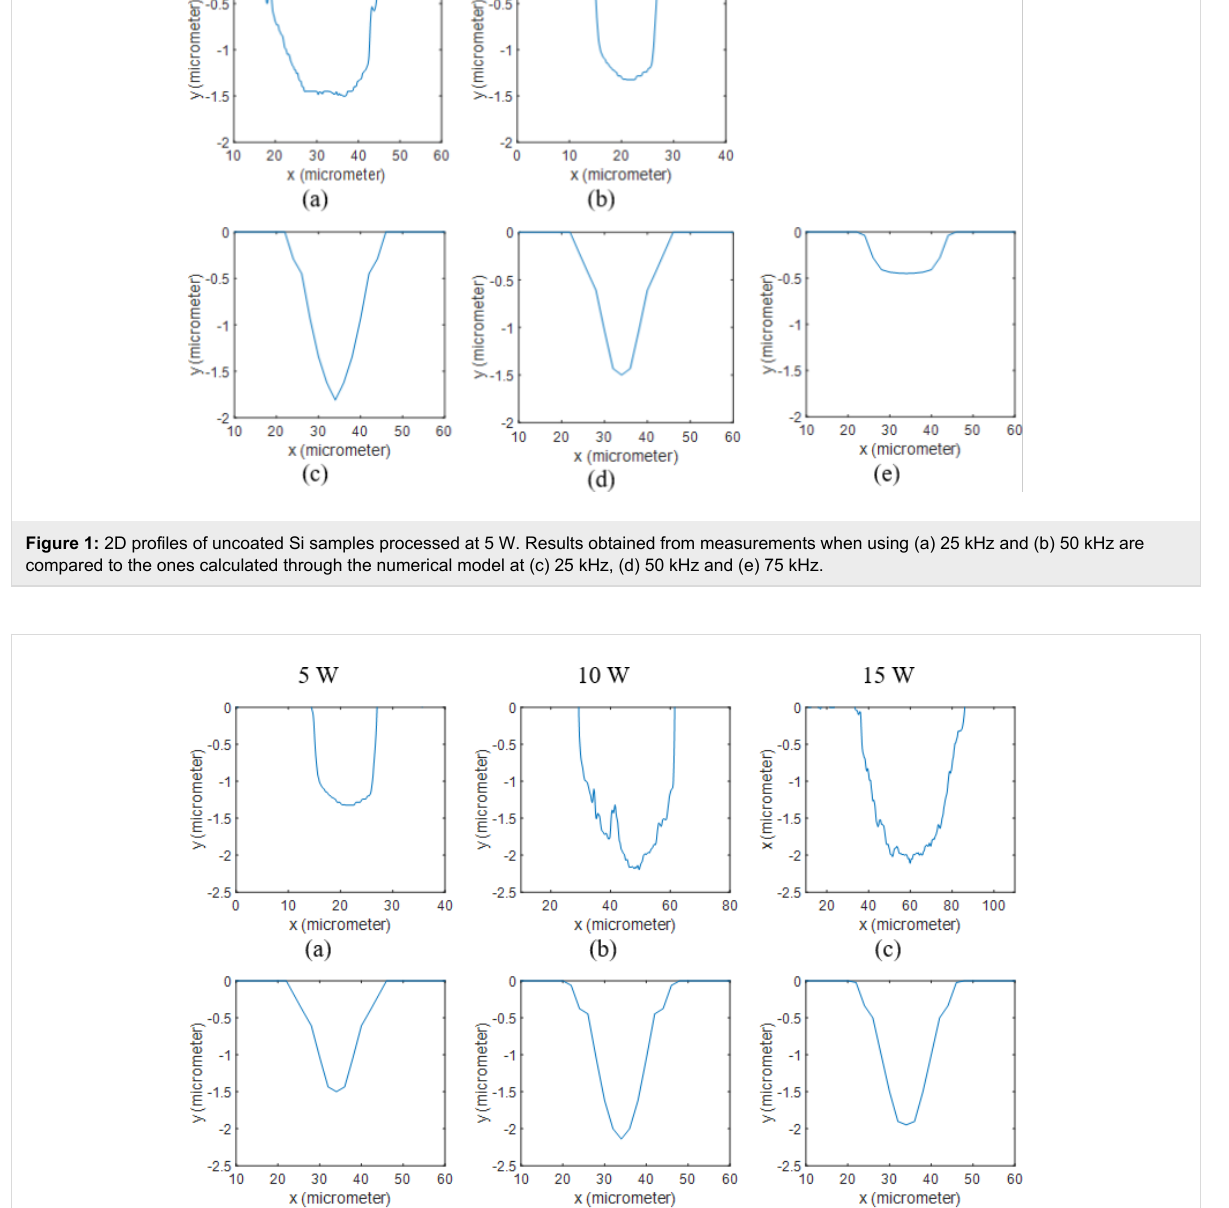
The diameters of the holes at low frequencies and high powers are slightly larger in the experimental results. The laser-driven shock wave and the flow of the molten silicon, which were not considered in the model, can explain the smaller calculated hole diameter.